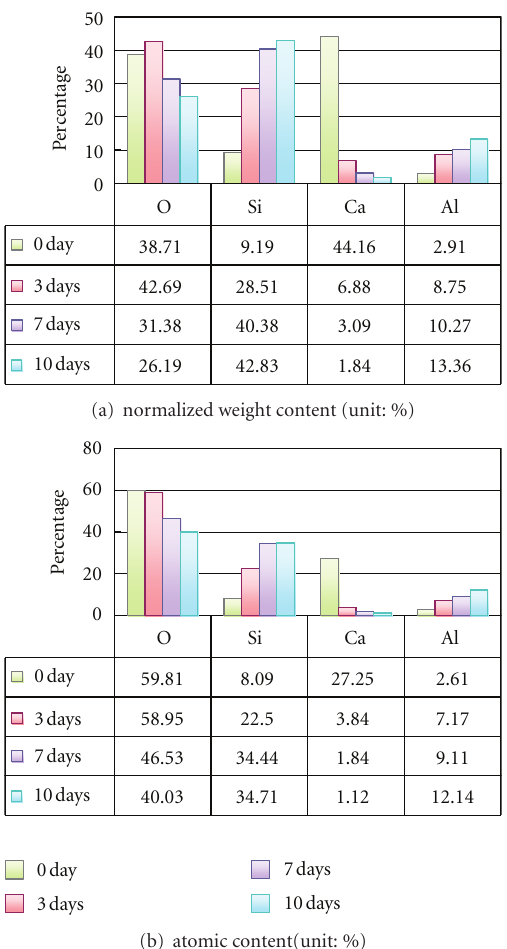
Figure 8: Pore recognition graph.